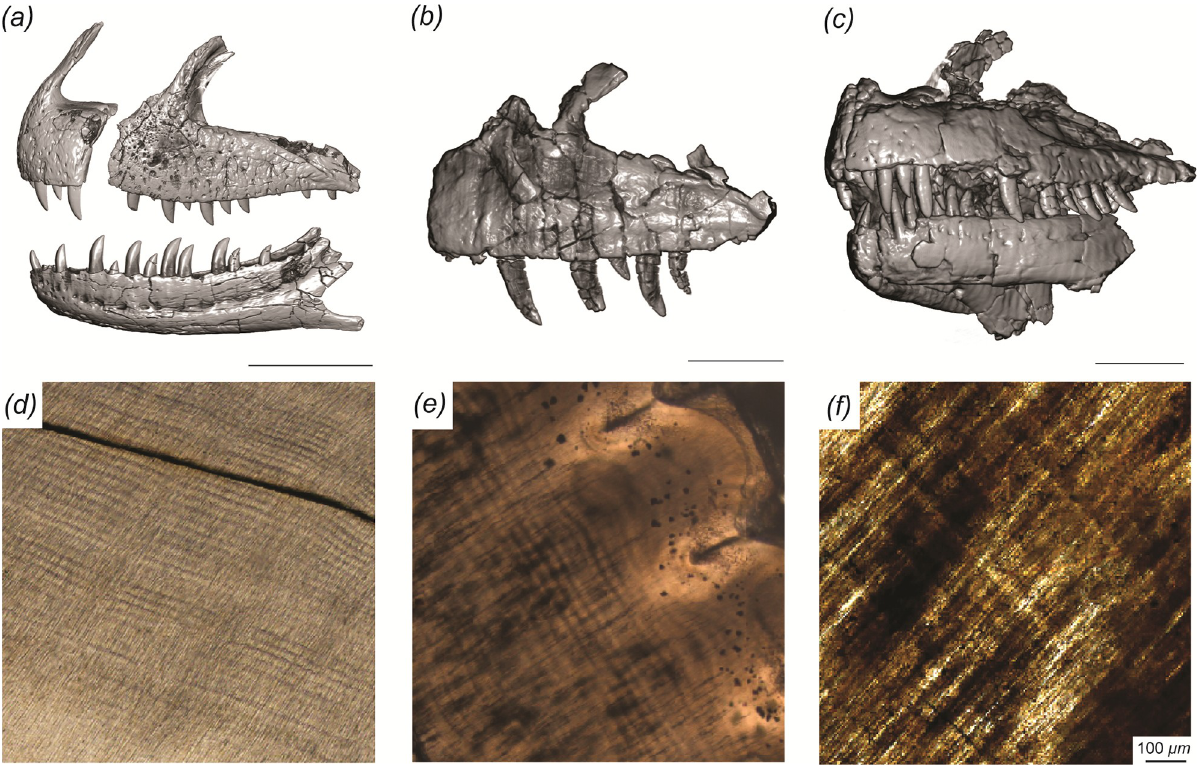
Fig 1. Craniofacial and dental histology of the theropod dinosaurs included in this study. (A) Majungasaurus (FMNH PR 2278), (B) Ceratosaurus (BYU 12893), and (C) Allosaurus (BYU 8901) surface reconstructions derived from computed tomography data and dentine histology. Scale bars below each cranial element(s) equal 10 cm. Histological sections derived from (D) Majungasaurus (DMNH EPV.134369), (E) Ceratosaurus (MWC 1), and (F) Allosaurus (BYU 2028), illustrating incremental daily lines (von Ebner) in dentine, which extend obliquely from upper left to lower right in each image. Scale bar of 100 μ m applies to